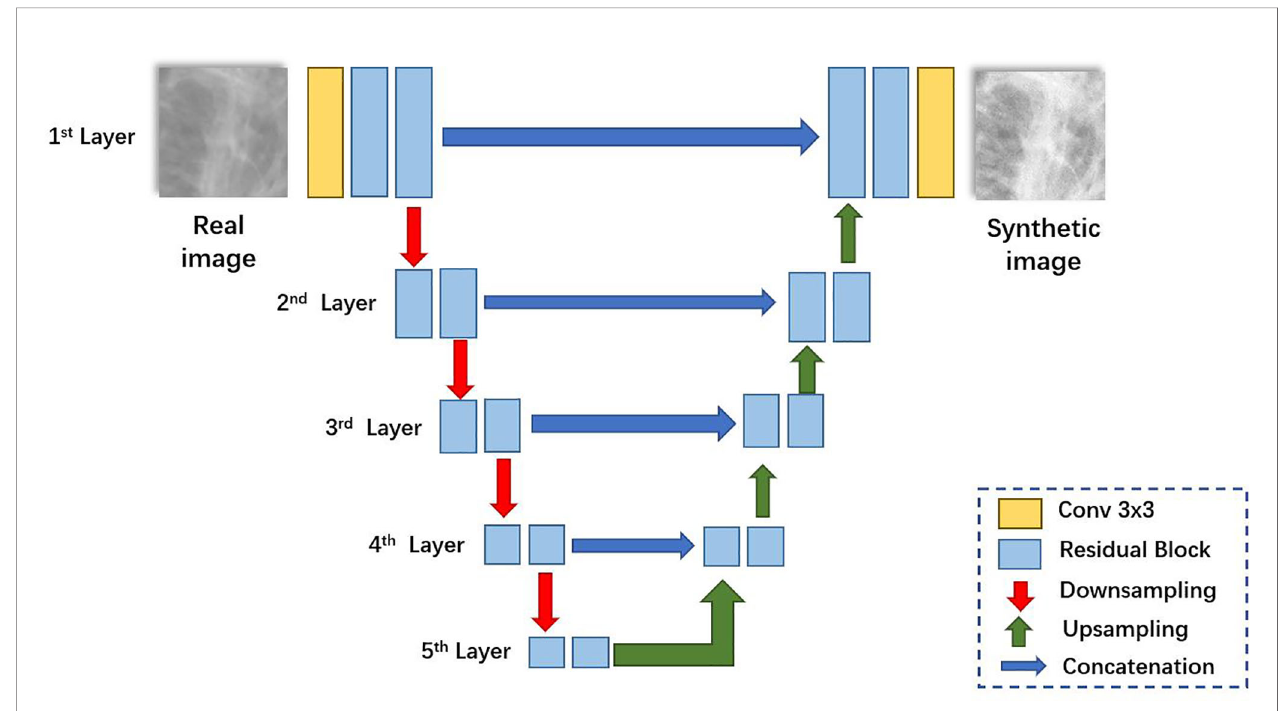
FIGURE 2 | The network architecture of the